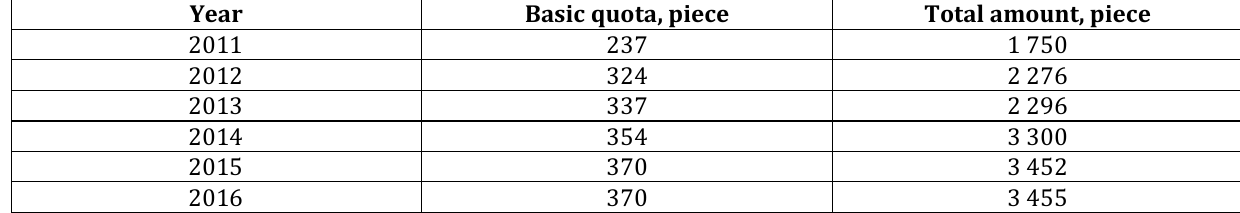
Table 1. Basic quota of ECMT license of for Ukrainian carriers according to the years Year